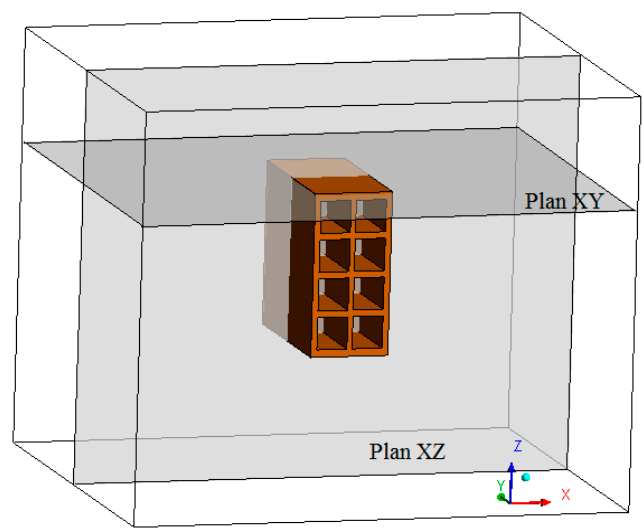
Figure 6. Planes XZ (Y = 0.1 m) and XY (Z = 0.196 m).